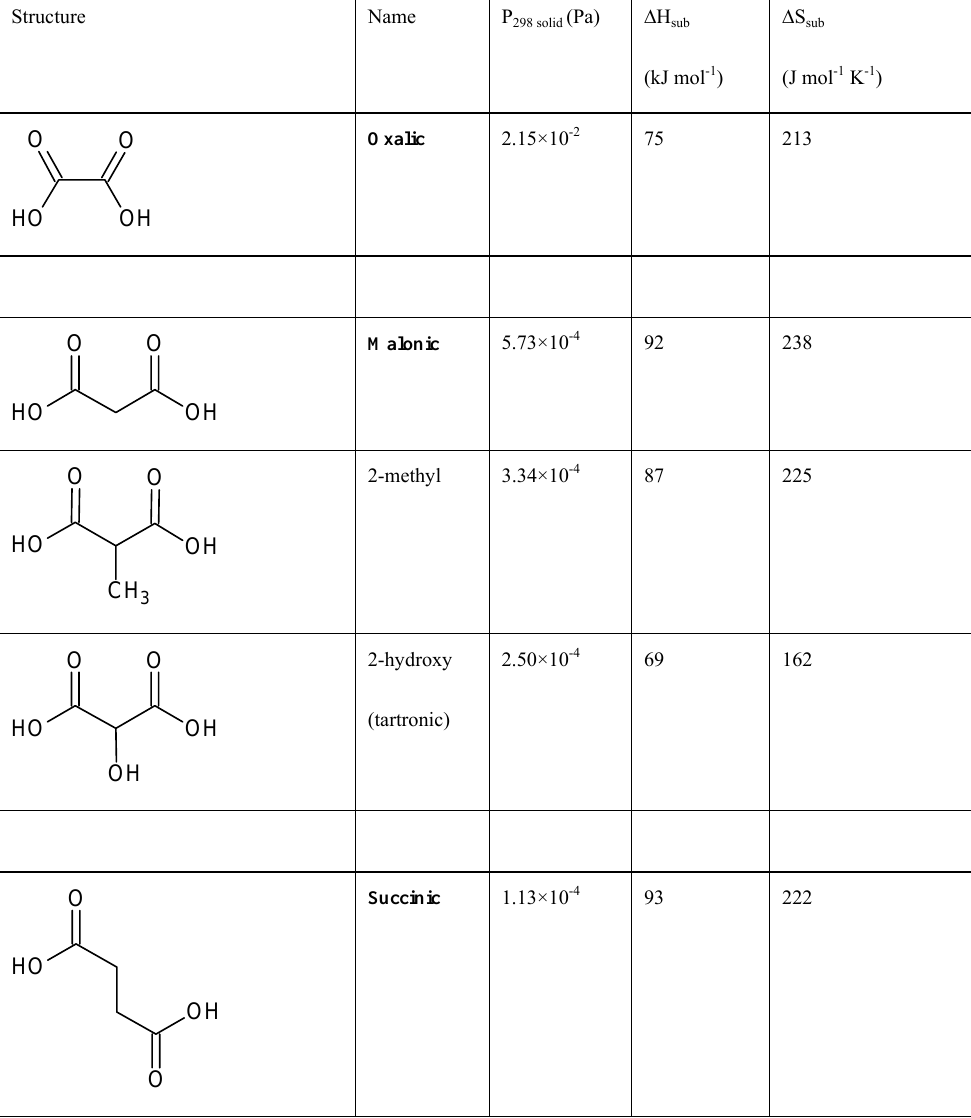
Table 1. KEMS determined solid state vapour pressures, enthalpies of sublimation and entropies of sublimation. Estimated maximium error on P 298 solid ± 40%.